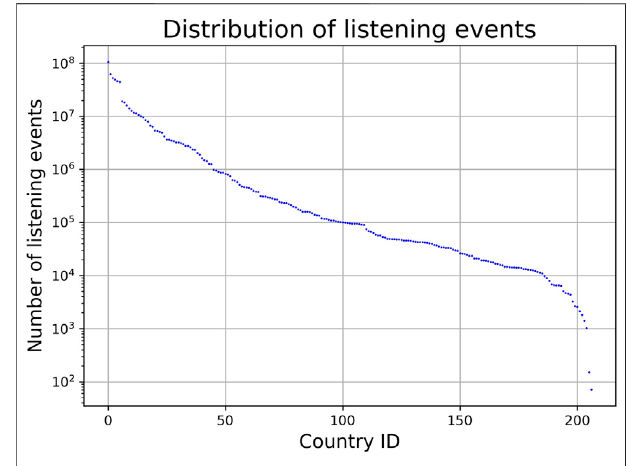
FIGURE 3 | Distribution of number of listening events over all tracks (semi-log-scaled). Track identi fi ers are ordered by number of LEs.